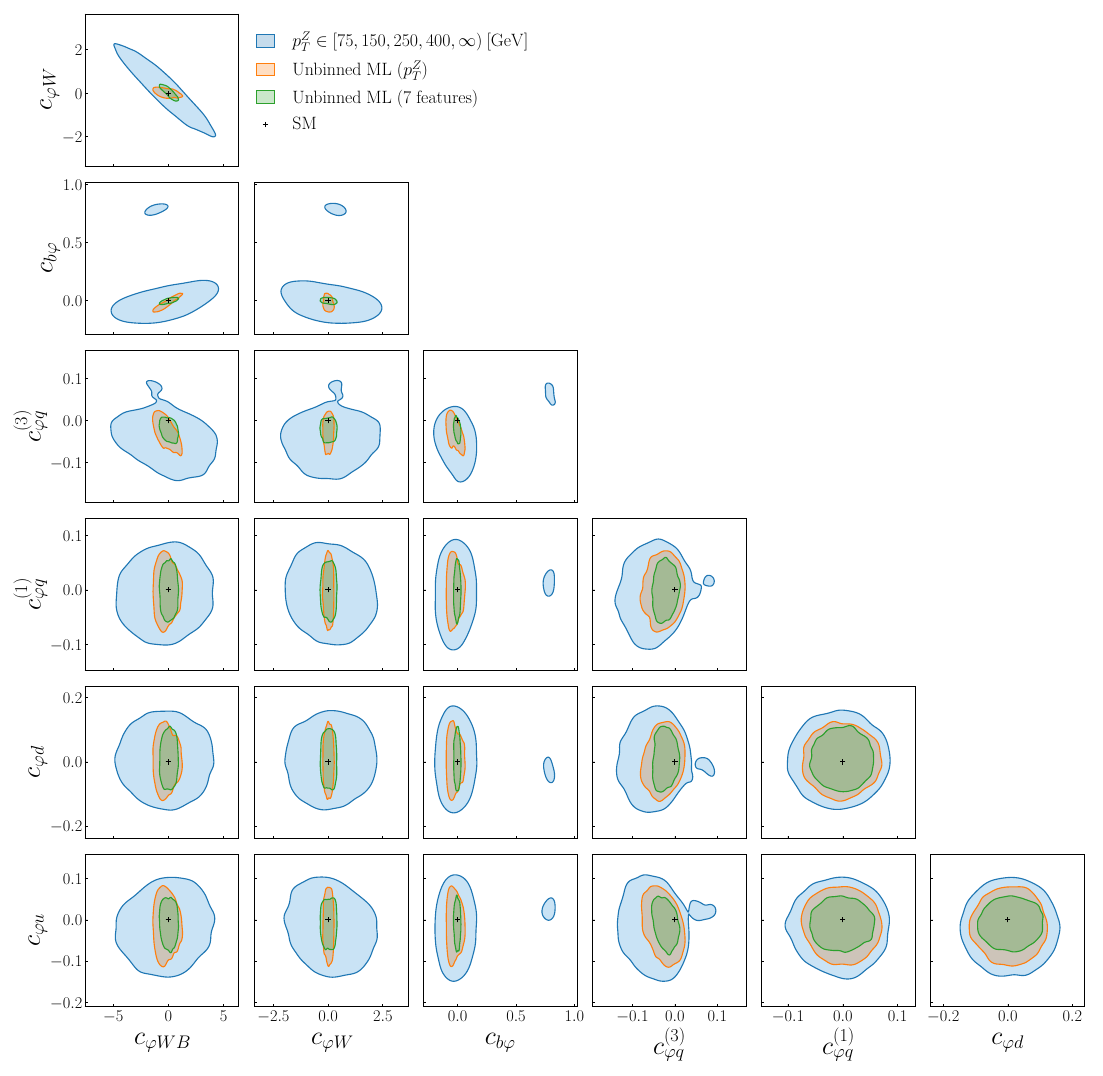
Figure 17. Same as figure 16 now where the 95% CL contours are obtained from the marginali- sation over the full posterior probability distribution, rather than from two-parameter